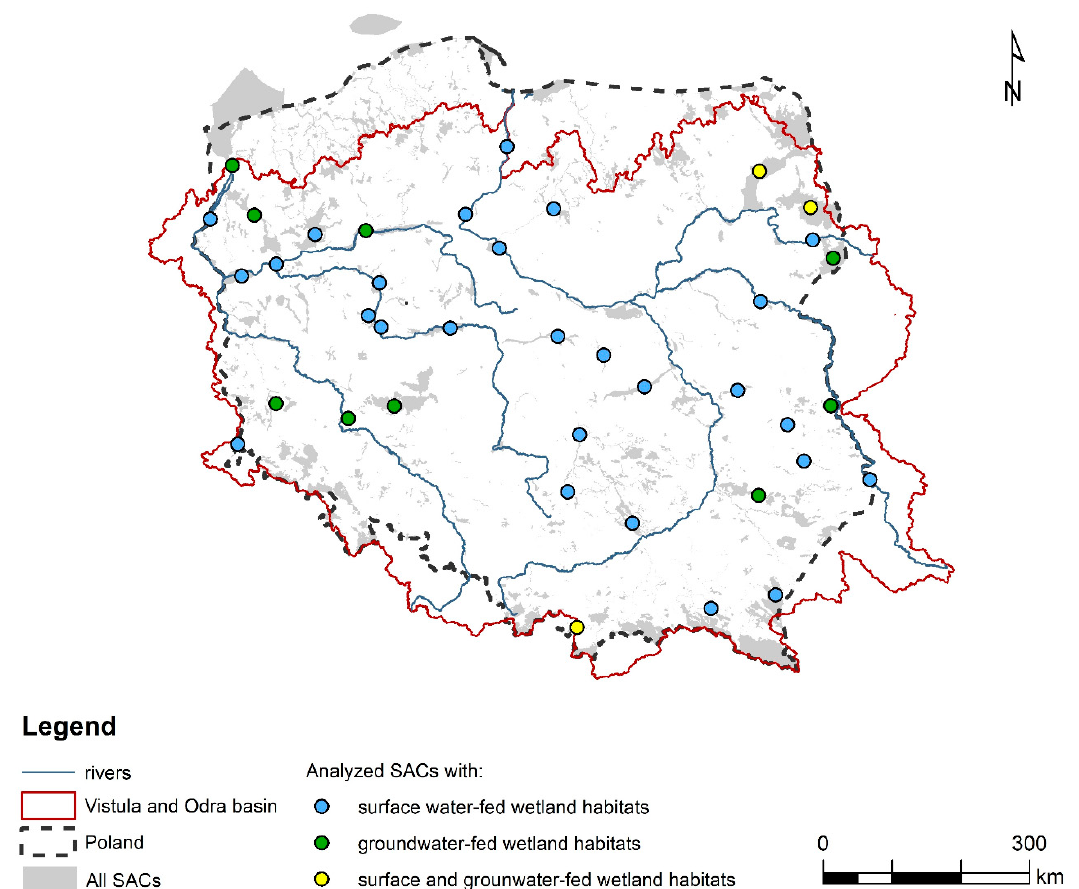
Figure 1. Location of special areas of conservation (SACs) within the Vistula and Odra basins (VOB) in Poland. Color coding represents the type of wetland habitats present in the SACs selected for analysis: groundwater-fed (green) and surface water-fed (blue) wetland habitats, and both types of habitats (yellow).